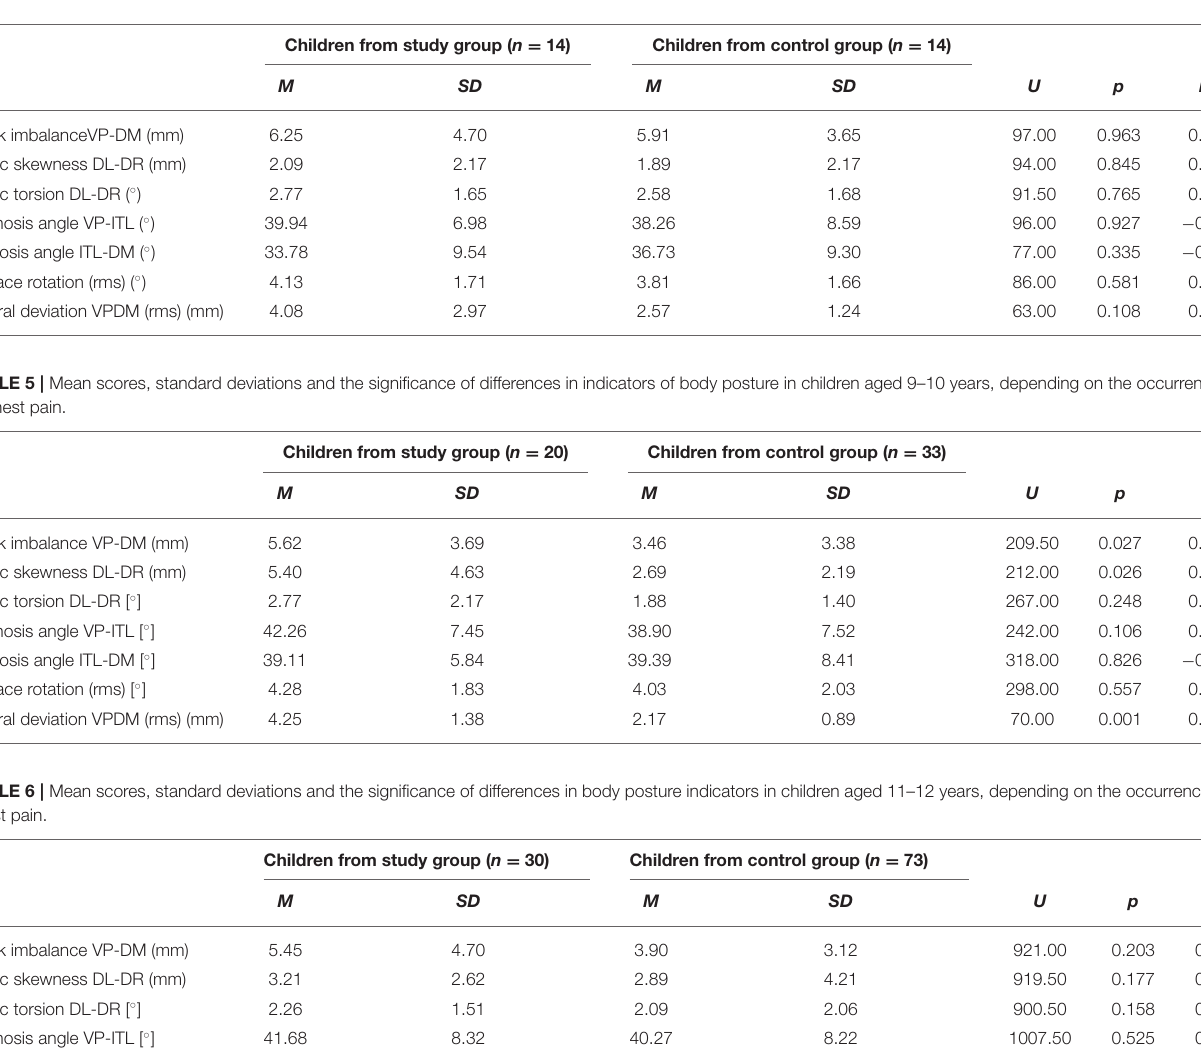
TABLE 4 | Mean scores, standard deviations and the significance of differences in indicators of body posture in children aged 7–8 years, depending on the appearance of pain. Children from study group ( n = 14) Children from control group ( n = 14) M SD